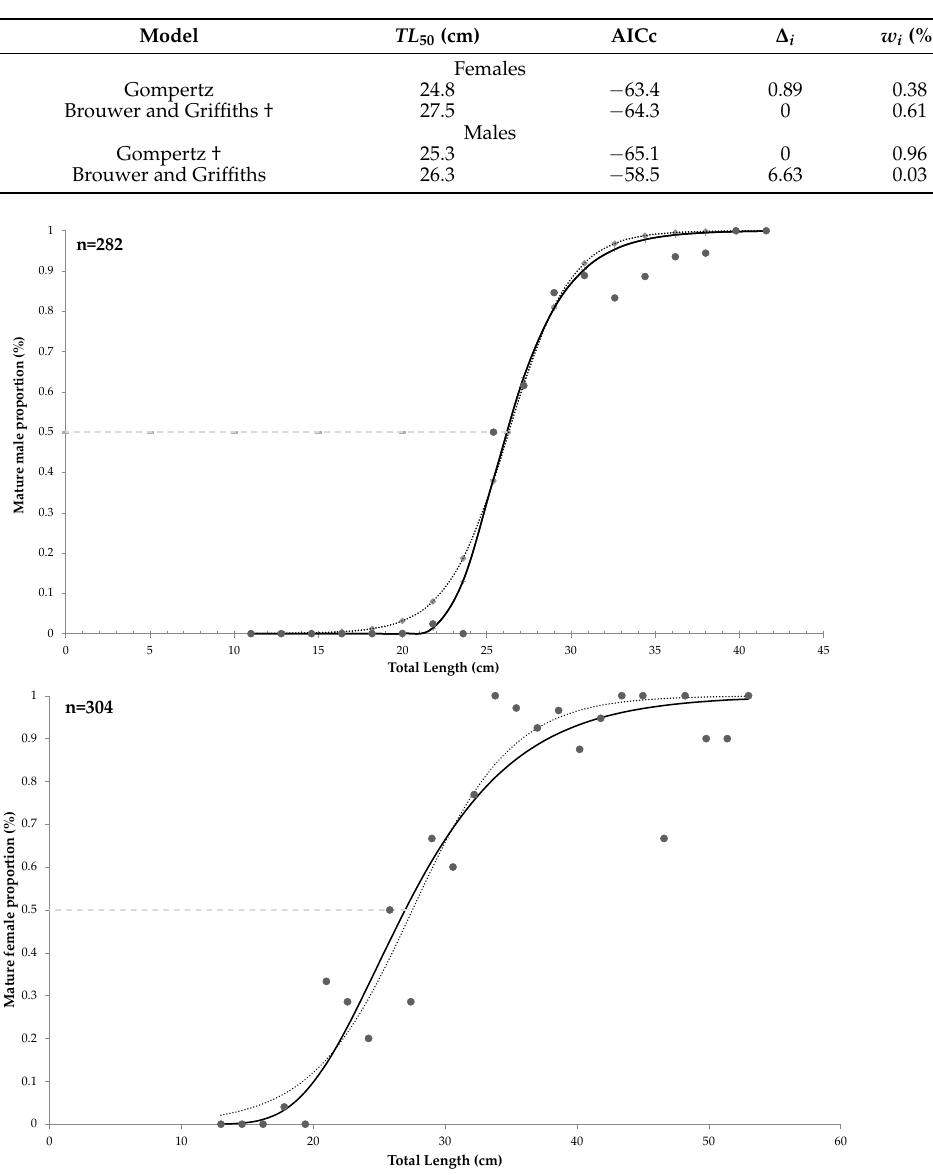
Table 2. The size at maturity ( TL 50 ) of Urotrygon chilensis in the Southern Gulf of California estimated with two models. The model selected as the best-fitted is marked with †. AICc = Akaike Information Criterion, ∆ i = Akaike’s difference, w i % = percentage weight of Akaike.